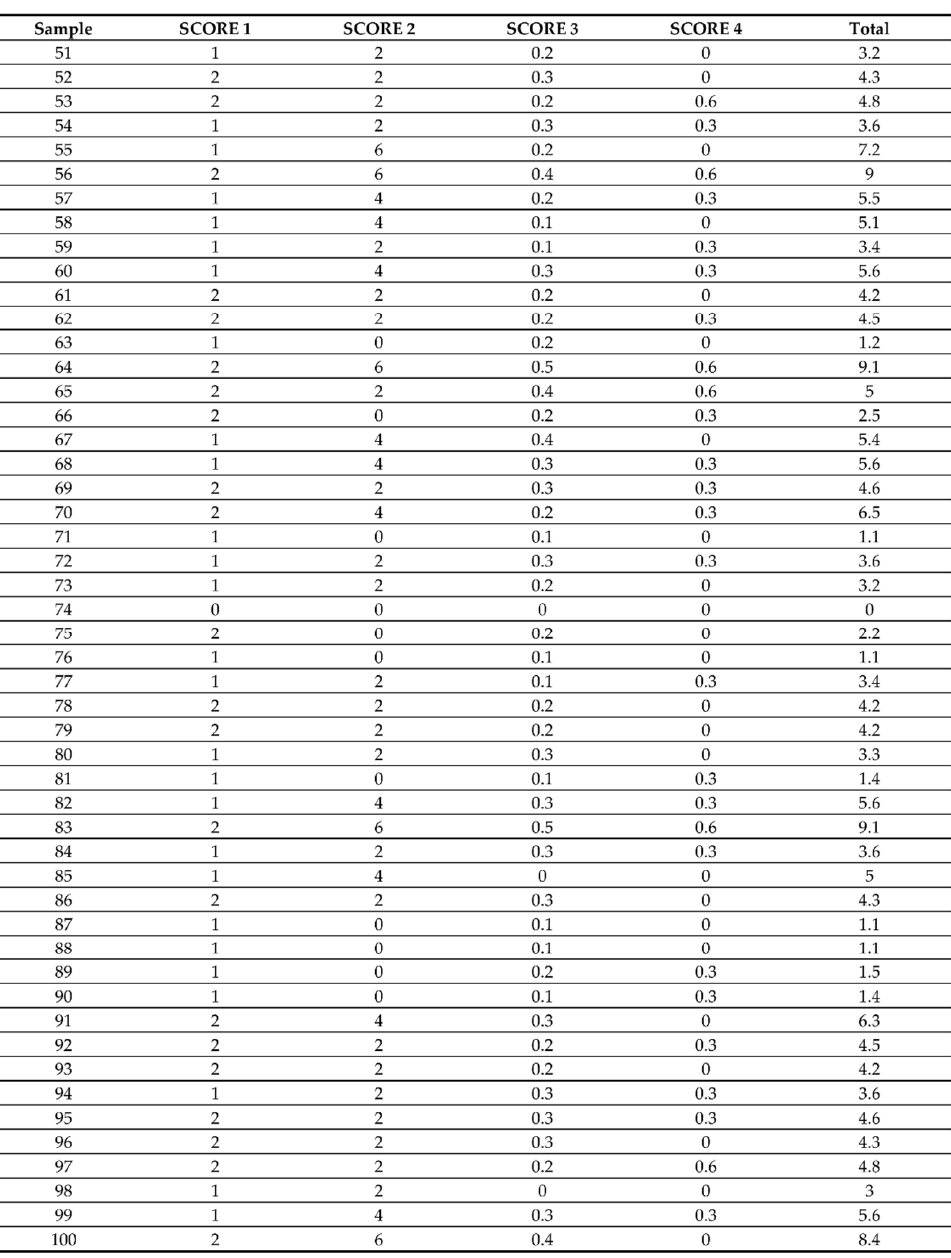
Figure A2. Space Time Scan Statistics results summary (last 50 samples).